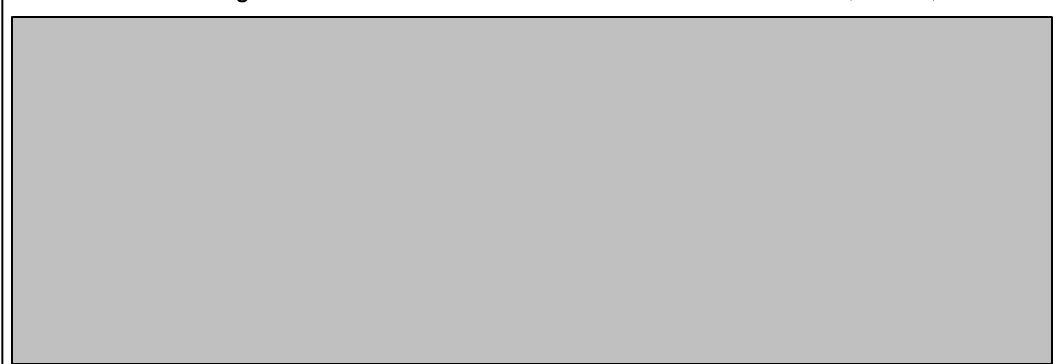
Table I: Age and sex distribution of students in 6 different schools. (n =